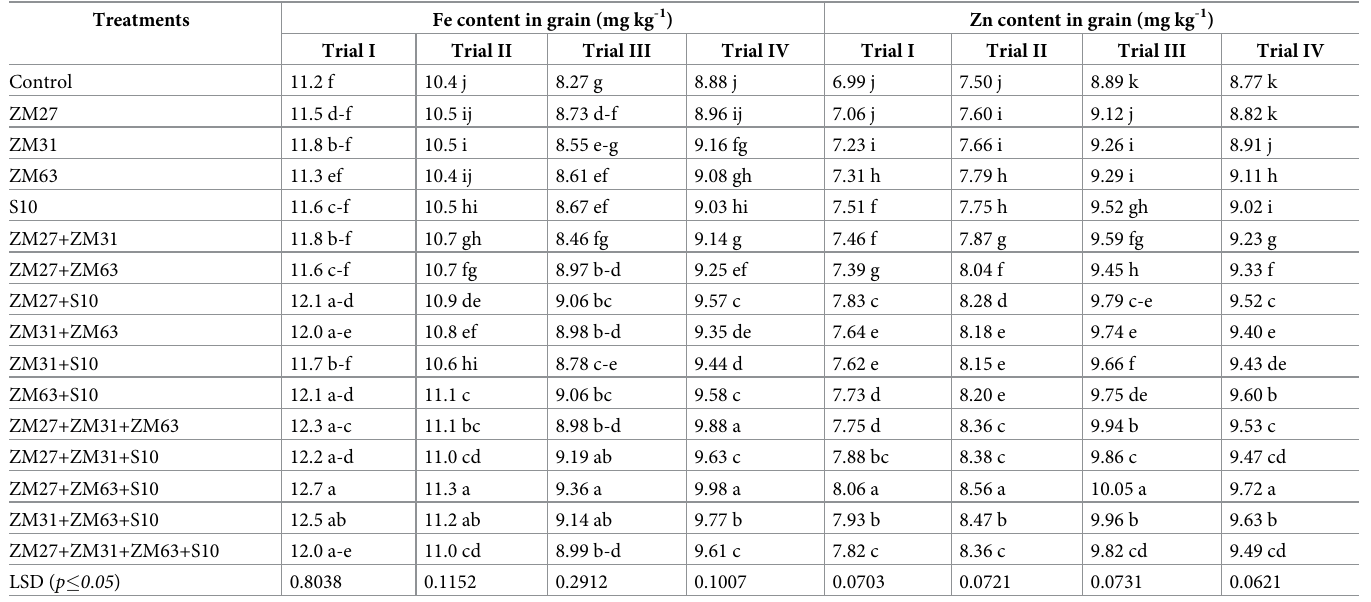
Table 5. Effects of novel bio-inoculants on iron and zinc content in grains of wheat in a field trial. Treatments